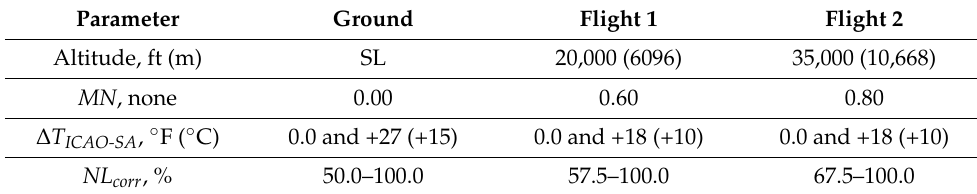
Table 6. Flight conditions for model